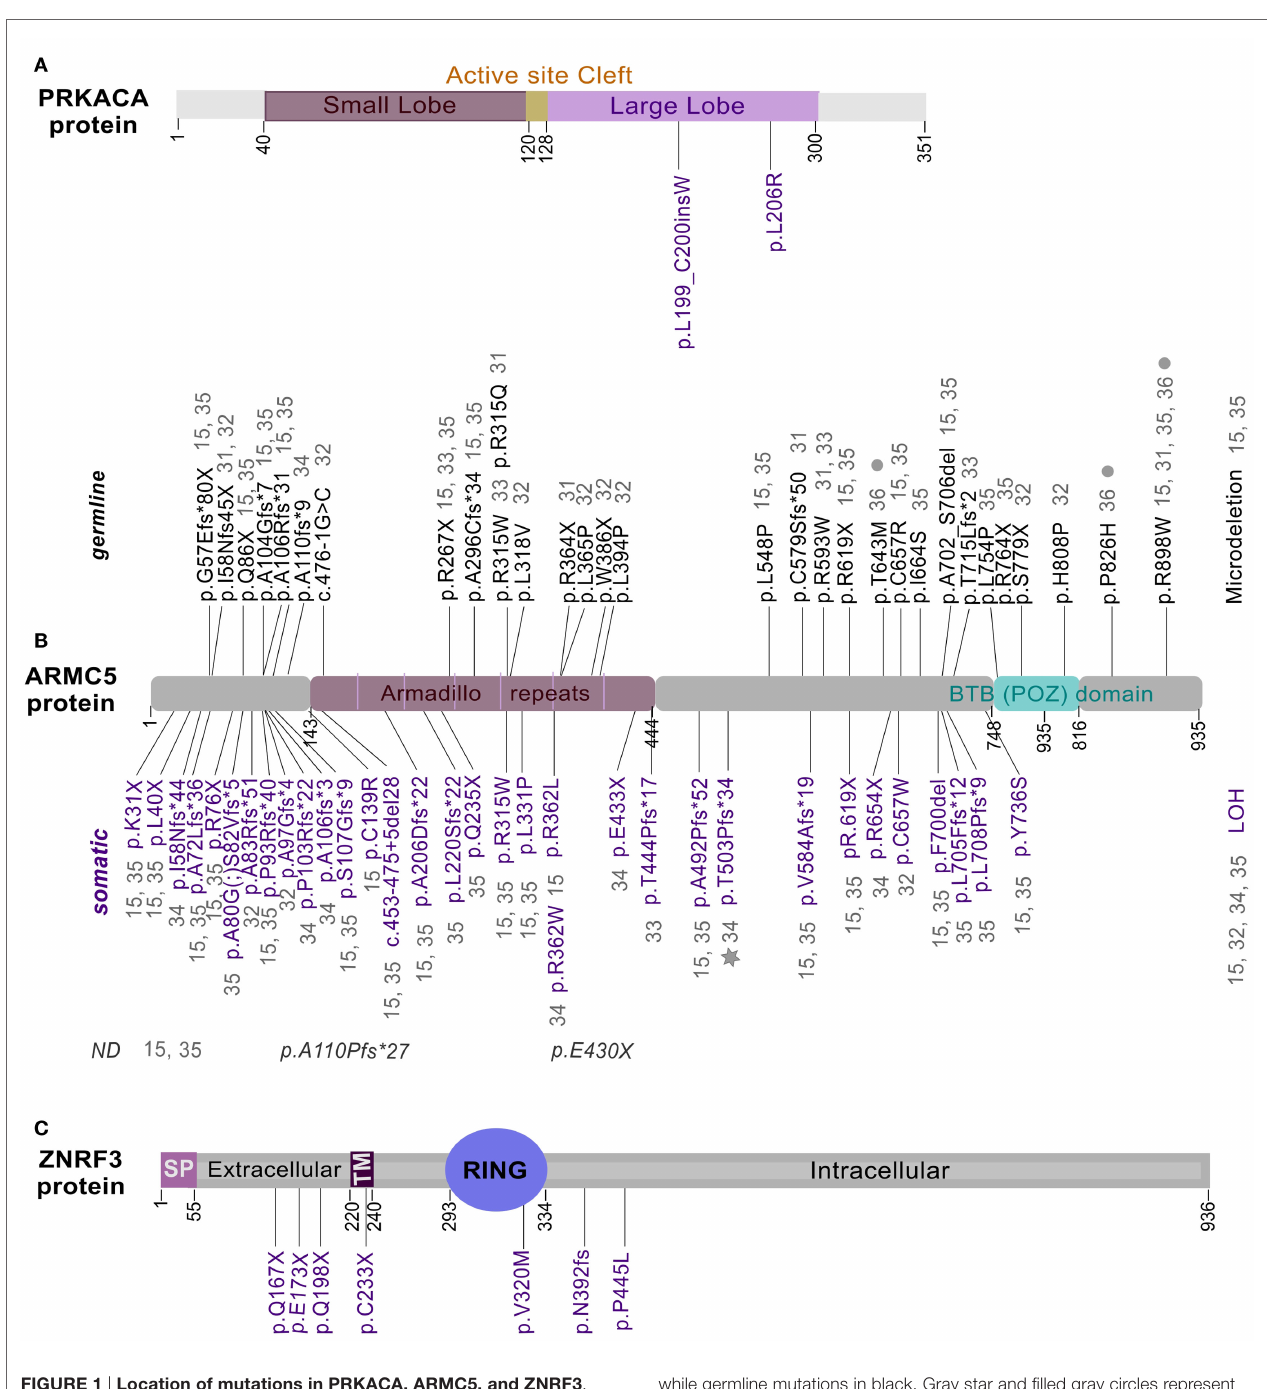
FiguRe 1 | Location of mutations in PRKACA, ARMC5, and ZnRF3 . Full length of PRKACA (A) , ARMC5 (B) , and ZNRF3 (C) proteins were represented with mutations identified in ACA-S (14, 21–24), PBMAH (15, 27–32), and ACC (16), respectively. Somatic mutations are shown in purple,